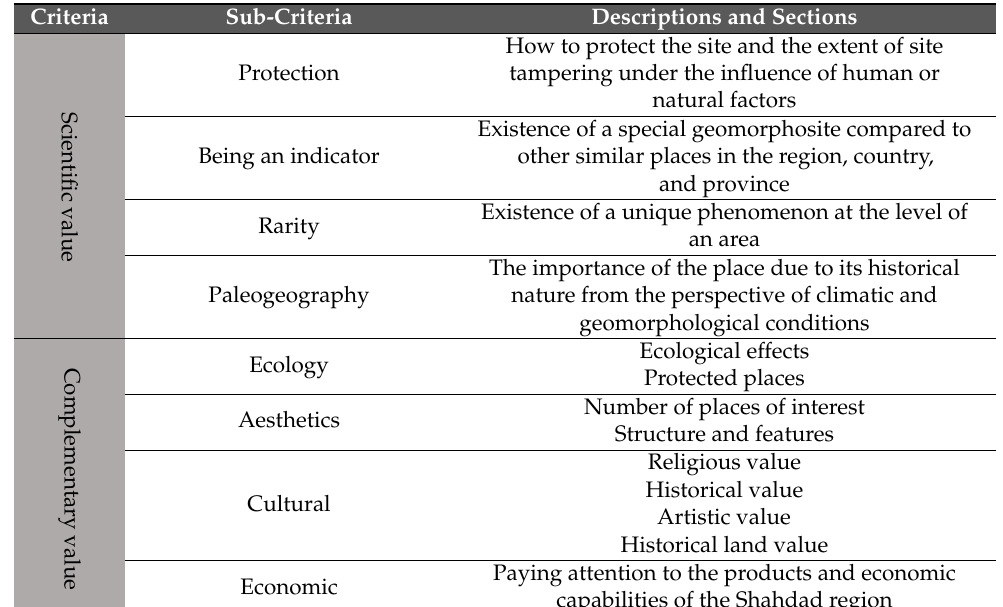
Table 6. Evaluation of scientific and complementary geomorphic value based on the Reynard method. Criteria Sub-Criteria Descriptions and Sections How to protect the site and the extent of Protection